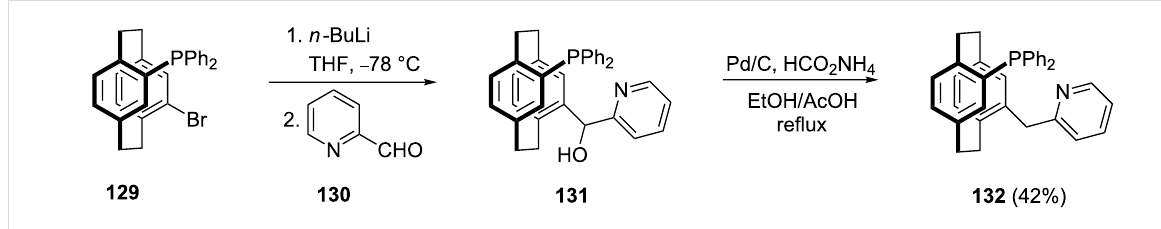
Scheme 25: Synthesis of paracyclophane pyridylphosphine ligands.